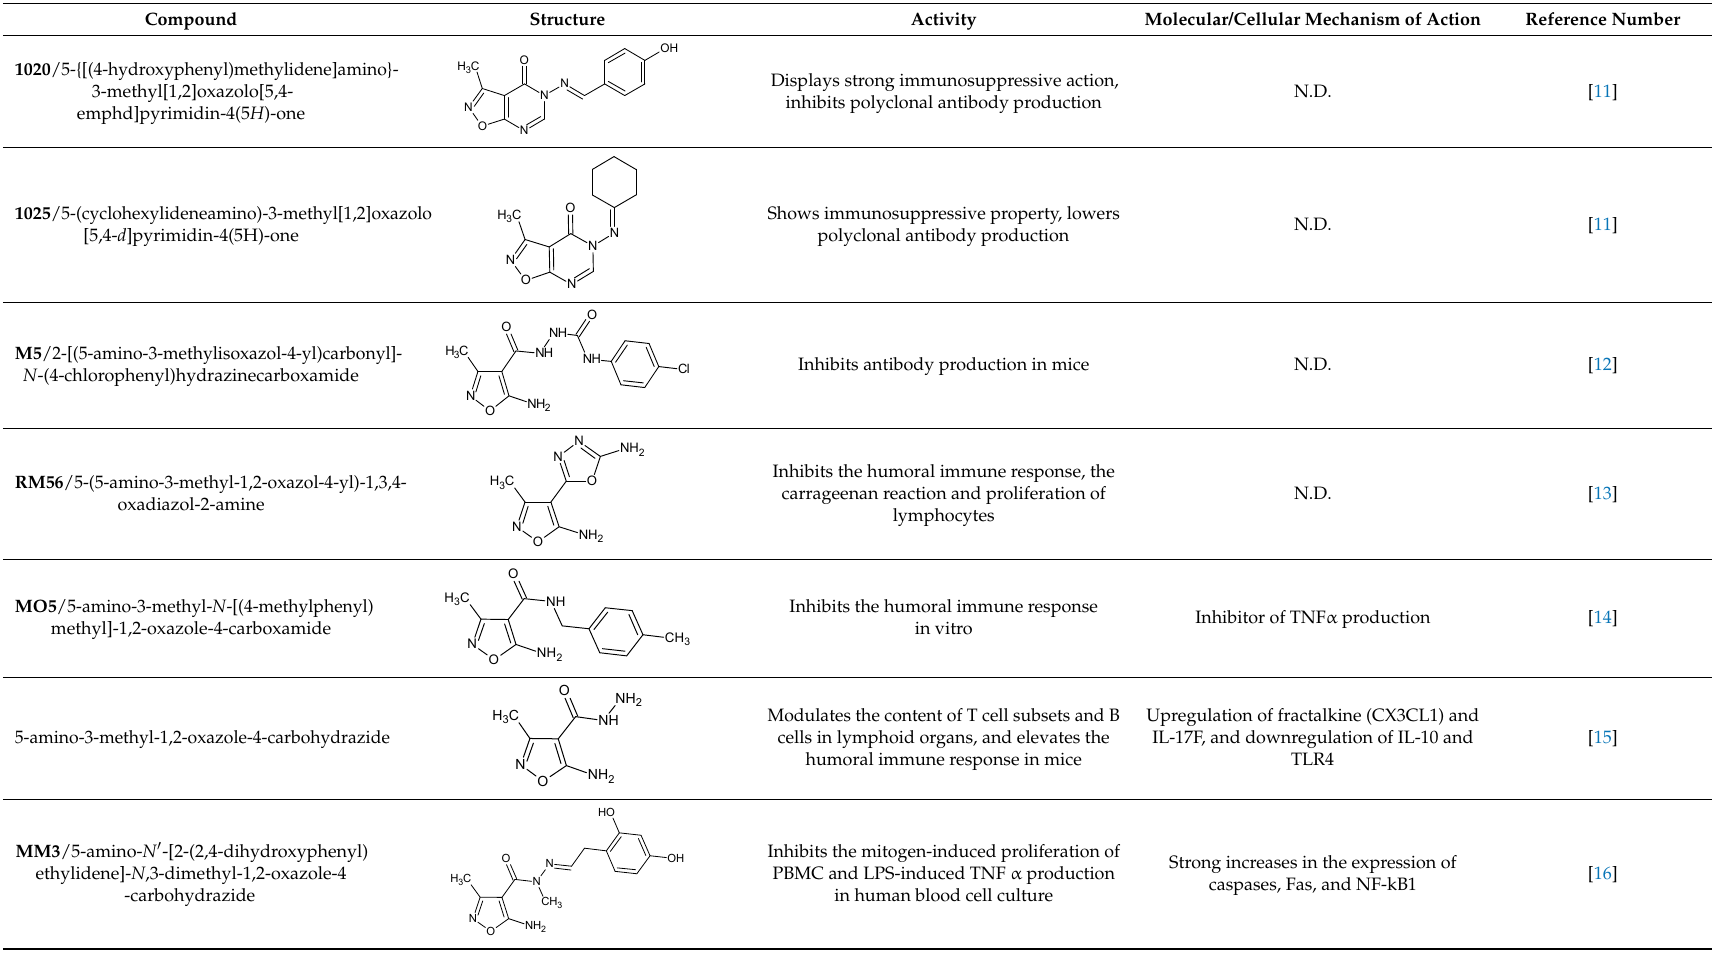
N.D. Displays strong immunosuppressive